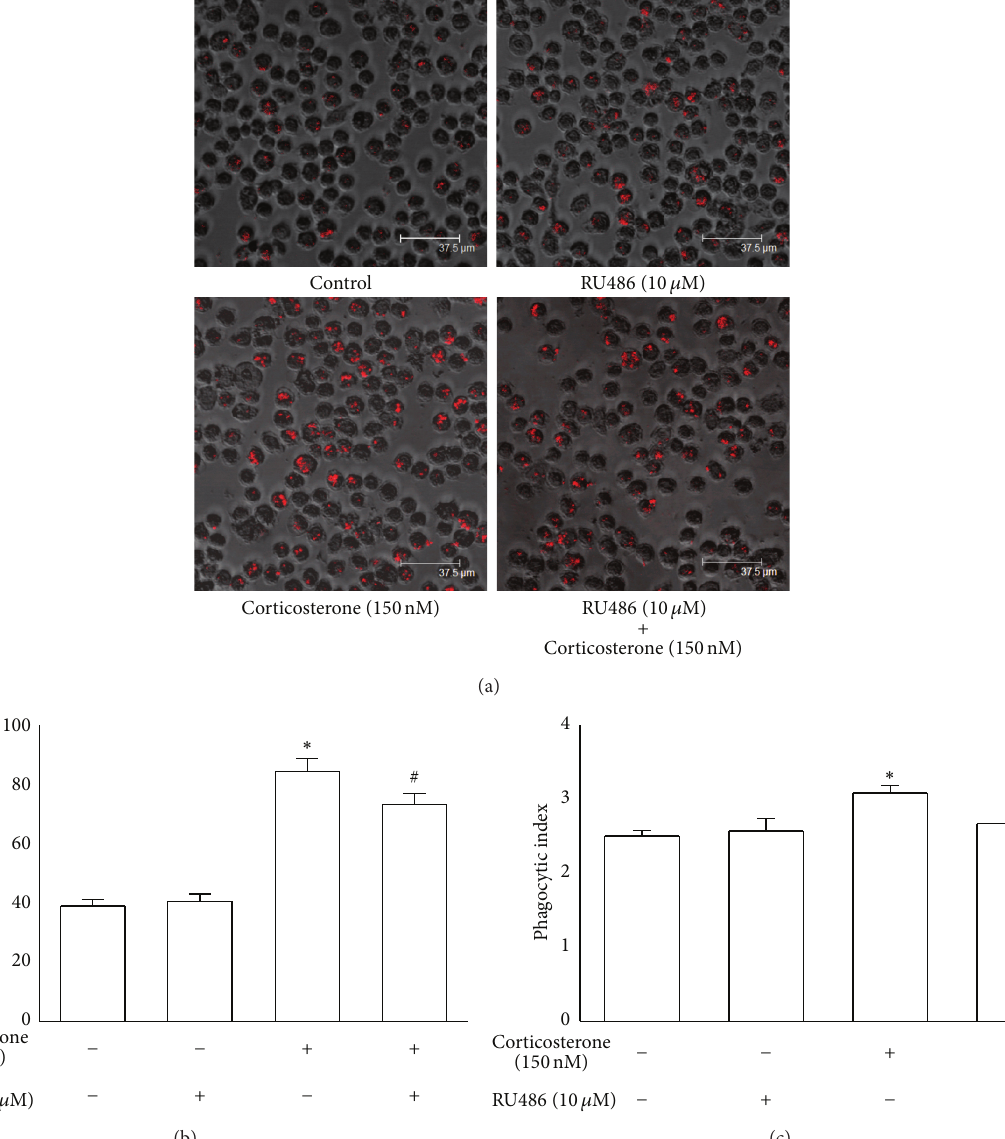
Figure 4: Effects of low concentration of corticosterone on the phagocytosis of rat peritoneal macrophages in the presence or absence of RU486. (a) Rat peritoneal macrophages were treated with vehicle diluent (ethanol) as a control group. Macrophages were treated with RU486 (10 𝜇 M), corticosterone (150nM), and RU486 (10 𝜇 M) plus corticosterone (150nM), respectively. Scale bar, 37.5 𝜇 m. The phagocytic activity wasestimatedbythephagocyticrate(b)andindex(c).Theresultswererepresentativeoffiveindependentexperimentsperformedontriplicate samples. ∗ 𝑃 < 0.01 versus the control group, # 𝑃 < 0.01 versus the corticosterone (150nM)